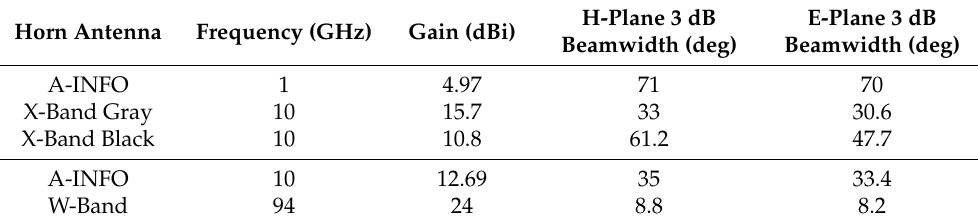
Table 3. Antennas used in the real tunnel experiments and their counterparts used in the respective scale models for frequencies of 1, 10, and 94